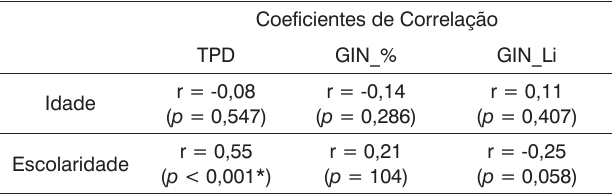
na Figura 2. DISCUSSÃO Os novos usuários de prótese auditiva desta pes- quisa foram acompanhados por um período mínimo de 12